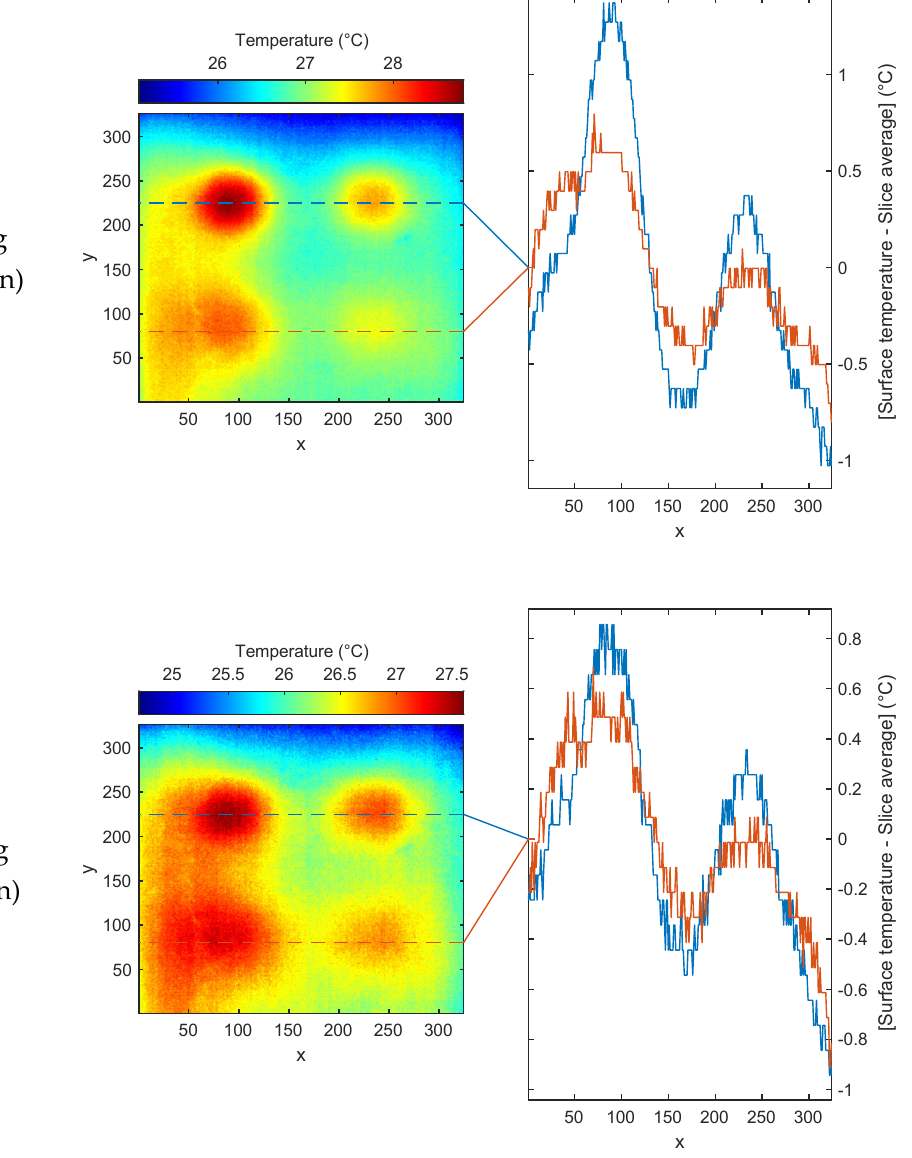
Figure 13. Selected thermal images at the end of ( a ) 7.5 min of cooling and ( b ) 15 min of cooling, in which the blue and red dashed lines correspond to temperature profiles over the sound and defective areas.